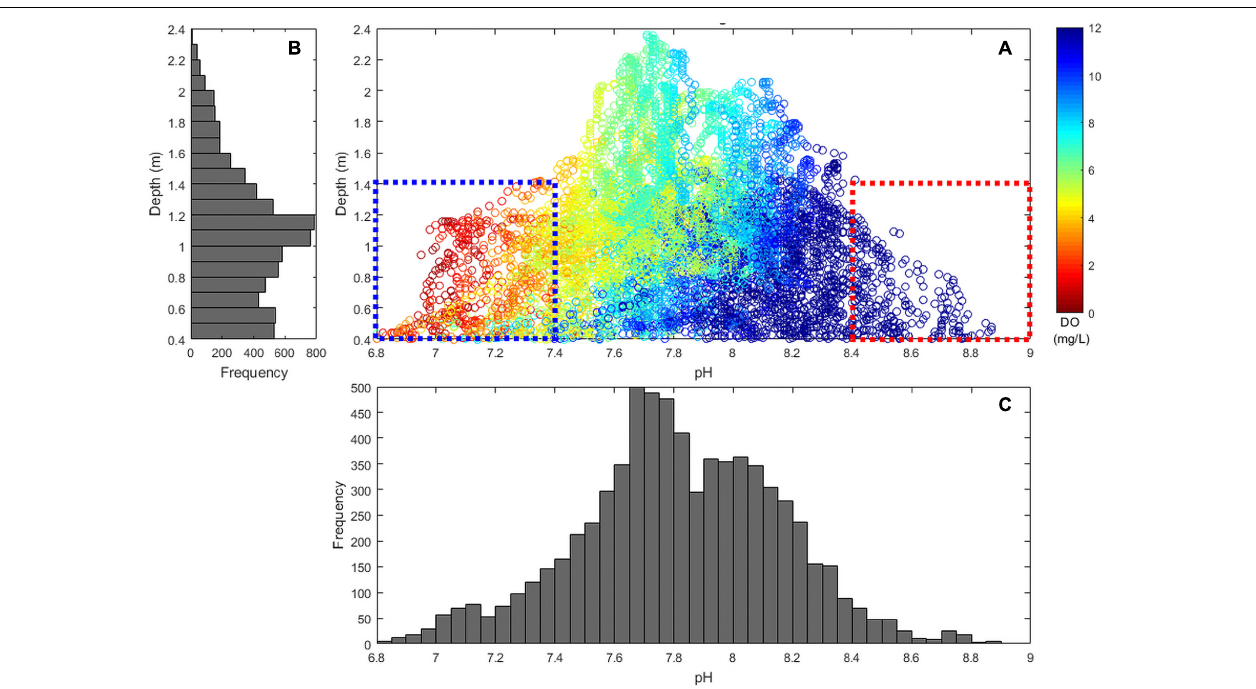
FIGURE 10 | Comparison of (A) depth (y-axis), pH T (x-axis), and DO (mg L − 1 ; color) in a macroalgal dominated ( Ulva sp.) region (MA-1), May–October, 2015. Blue dashed box indicates low pH T and DO during low tides and red dashed box indicates high pH T and DO during low tides. Frequency distribution of (B) depth and (C) pH T samples are indicated by adjacent